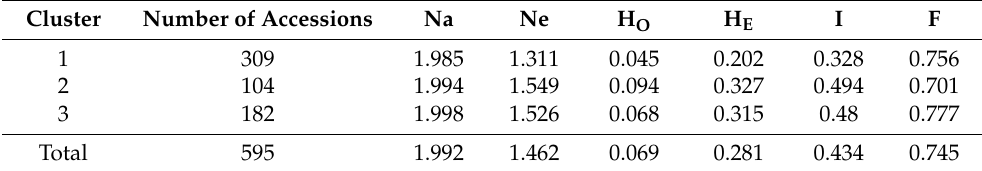
Table 2. The genetic diversity based on the genome wide SNPs among the three clusters. Cluster